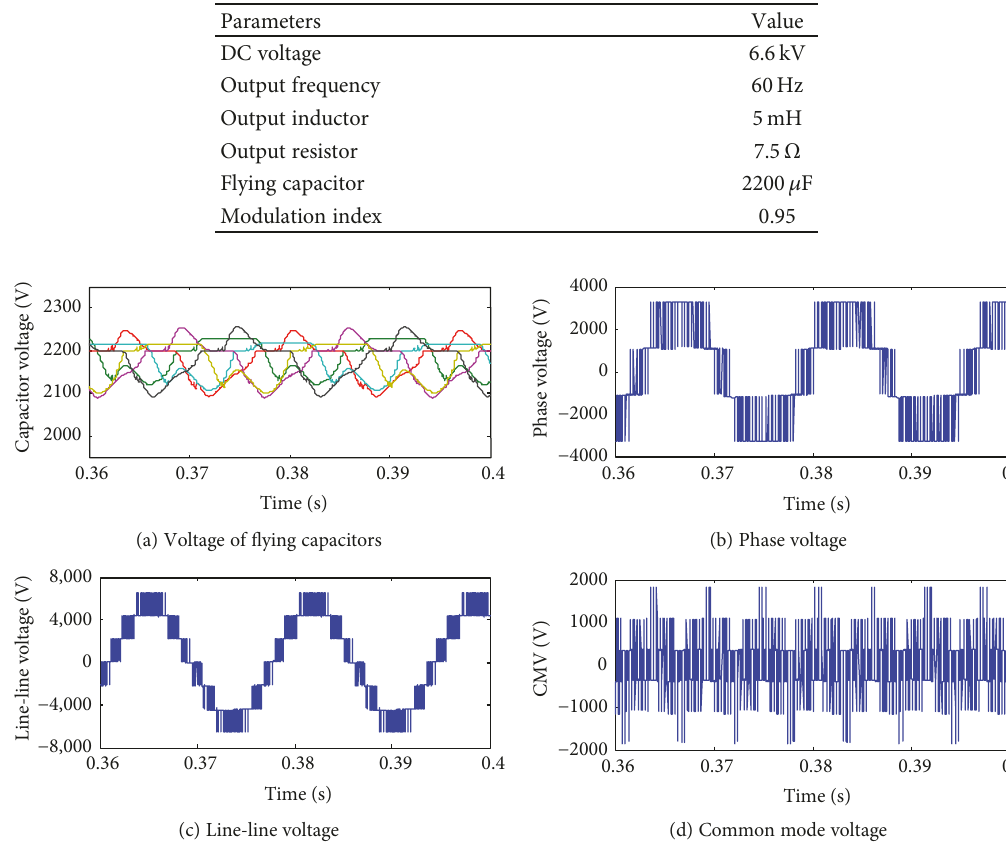
Figure 6: Simulation results (conventional